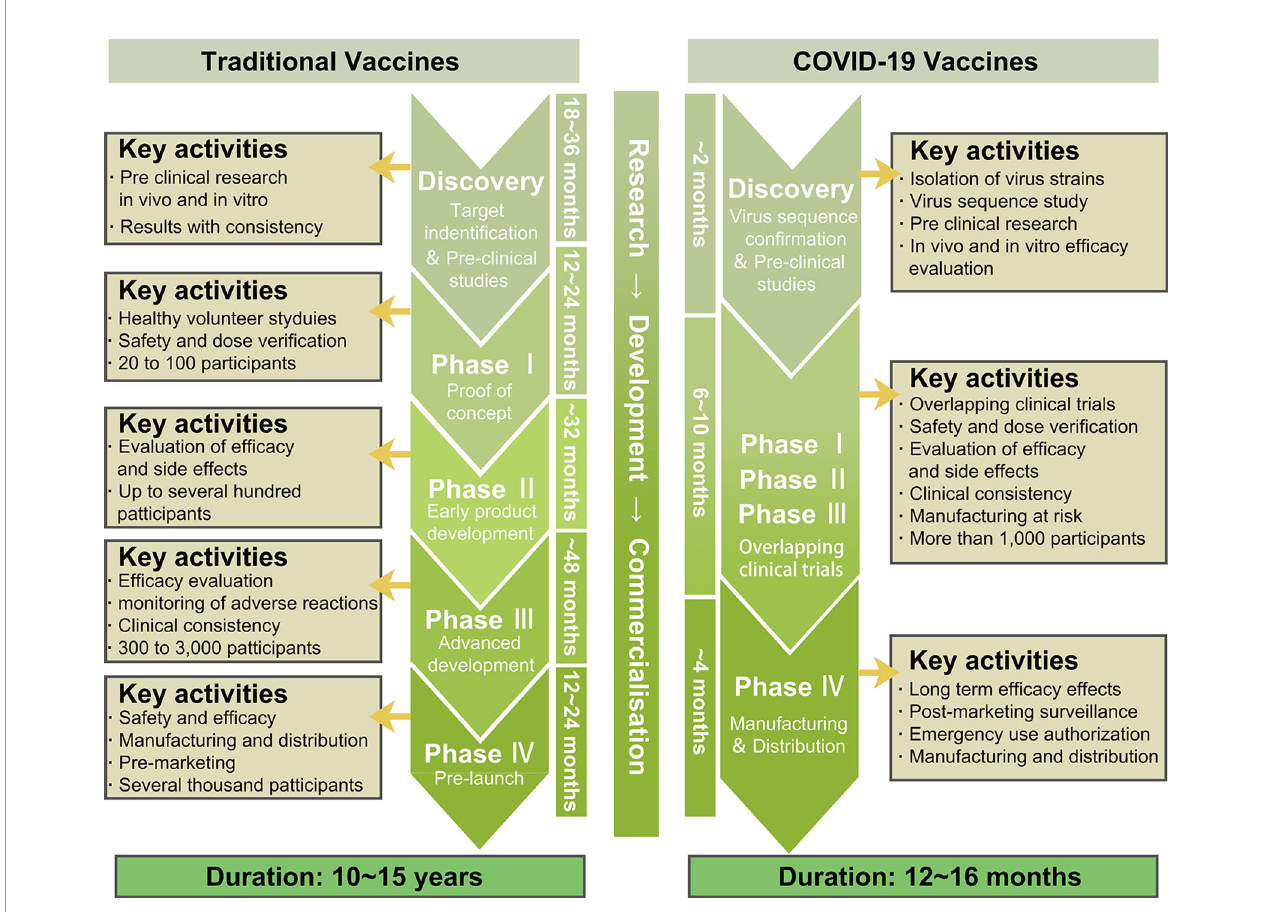
FIGURE 5 | The rapid development of COVID-19